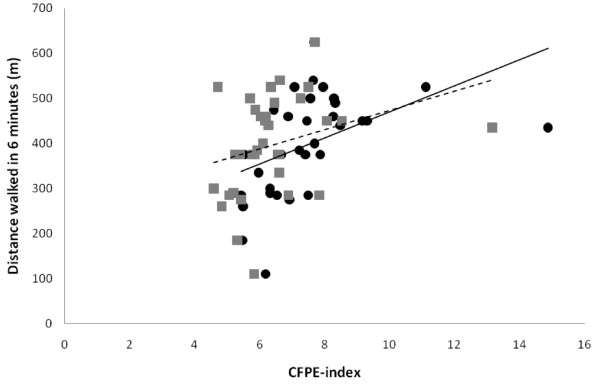
Relationship between distance walked in six minutes and CFPE-index for type I and type IIa fibres; "black circle" = type I fibres (-- = regression line for CFPE-index for type I fibres, r = 0.67, p < 0.001), "grey square"= type IIa fibres (-- = regression line for CFPE-index for type IIa fibres, r = 0.40, p = 0.02); CFPE-index = quotient between individual capillary-to-fibre ratio and fibre perimeter.